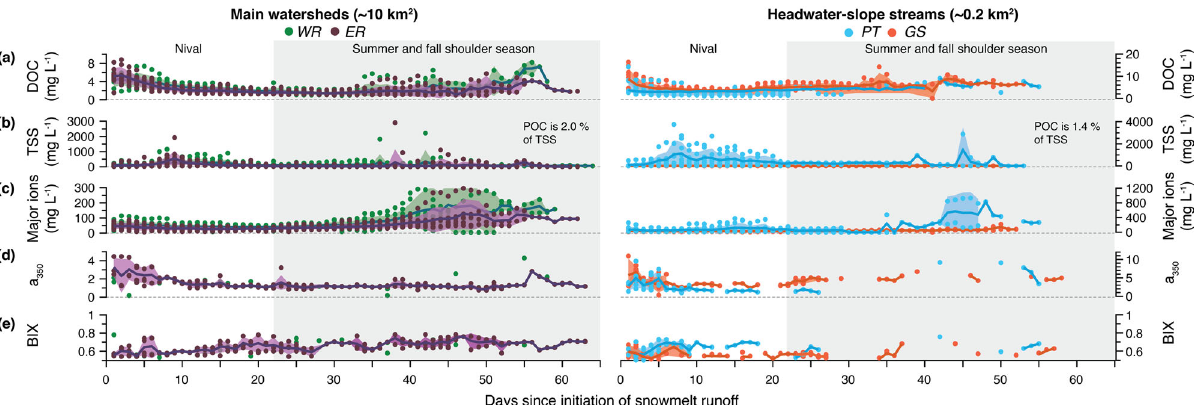
Fig. 4 Mean daily biogeochemical records normalized to the fi rst day of nival runoff and separated by watershed scale; main watersheds (~10 km 2 ): West River (WR); East River (ER); and headwater-slope streams (~0.2 km 2 ): Ptarmigan (PT); Goose (GS). ( a ) DOC concentration; ( b ) TSS concentration (note that POC is 1.4 – 2.0% of TSS in these systems); ( c ) major ions; ( d ) a350 values, which are an indicator of terrigenous DOM; and ( e ) BIX values which are an indicator of